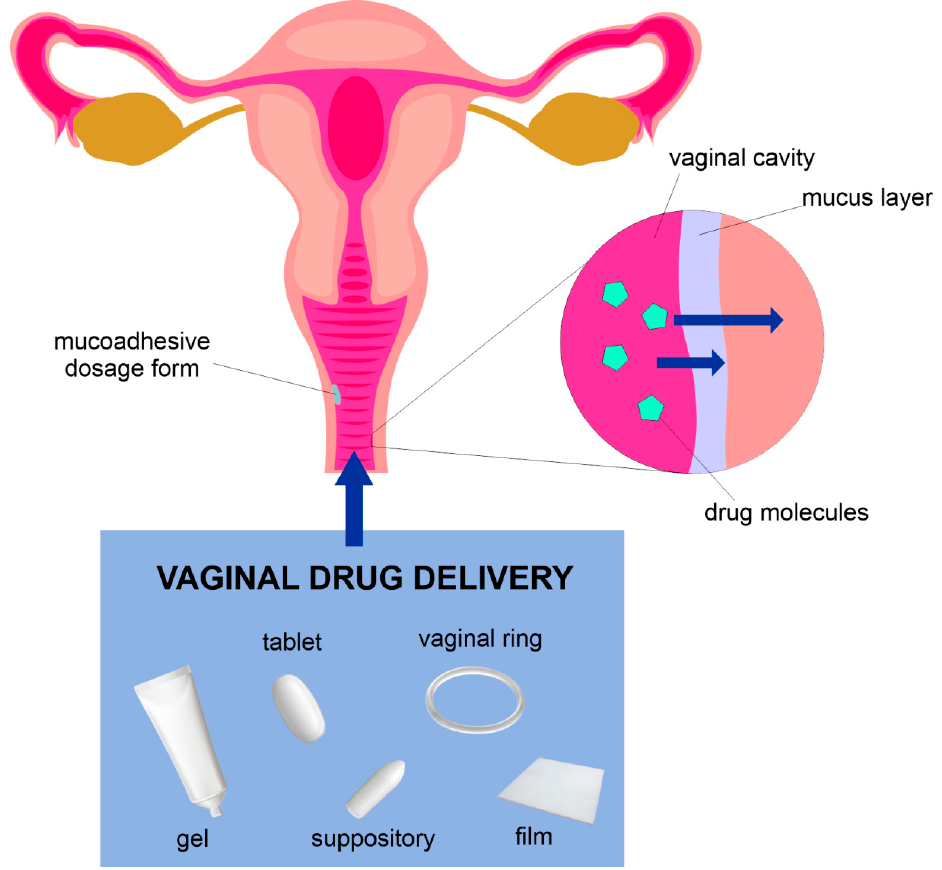
Figure 1. Vaginal drug delivery route.